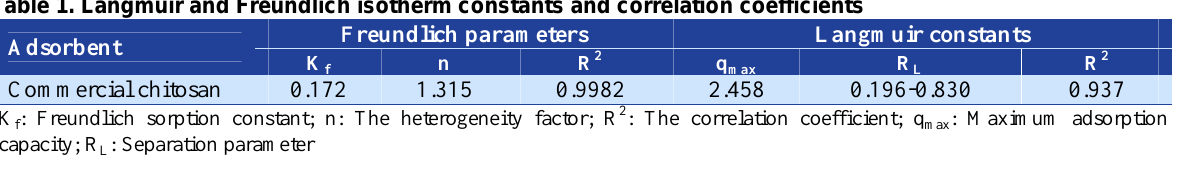
Table 2. Kinetic constants for arsenate onto chitosan Adsorbents